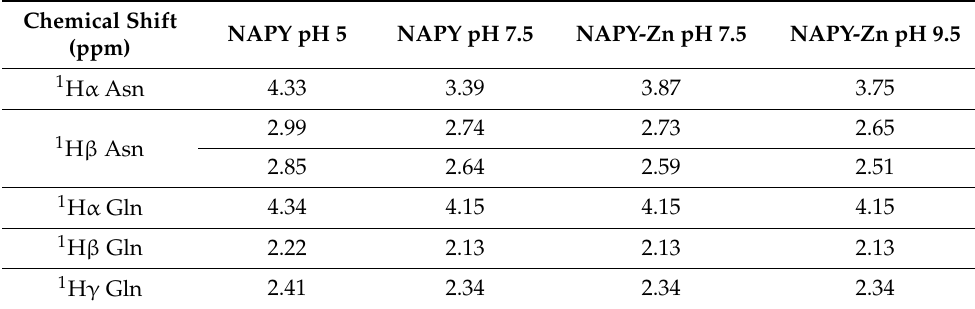
Table 3. Assignment of signal modifications from 1 H-NMR spectrum of NAP peptide at different value of pH and in the presence of zinc ions. Chemical Shift NAPY pH 5 NAPY pH (ppm)